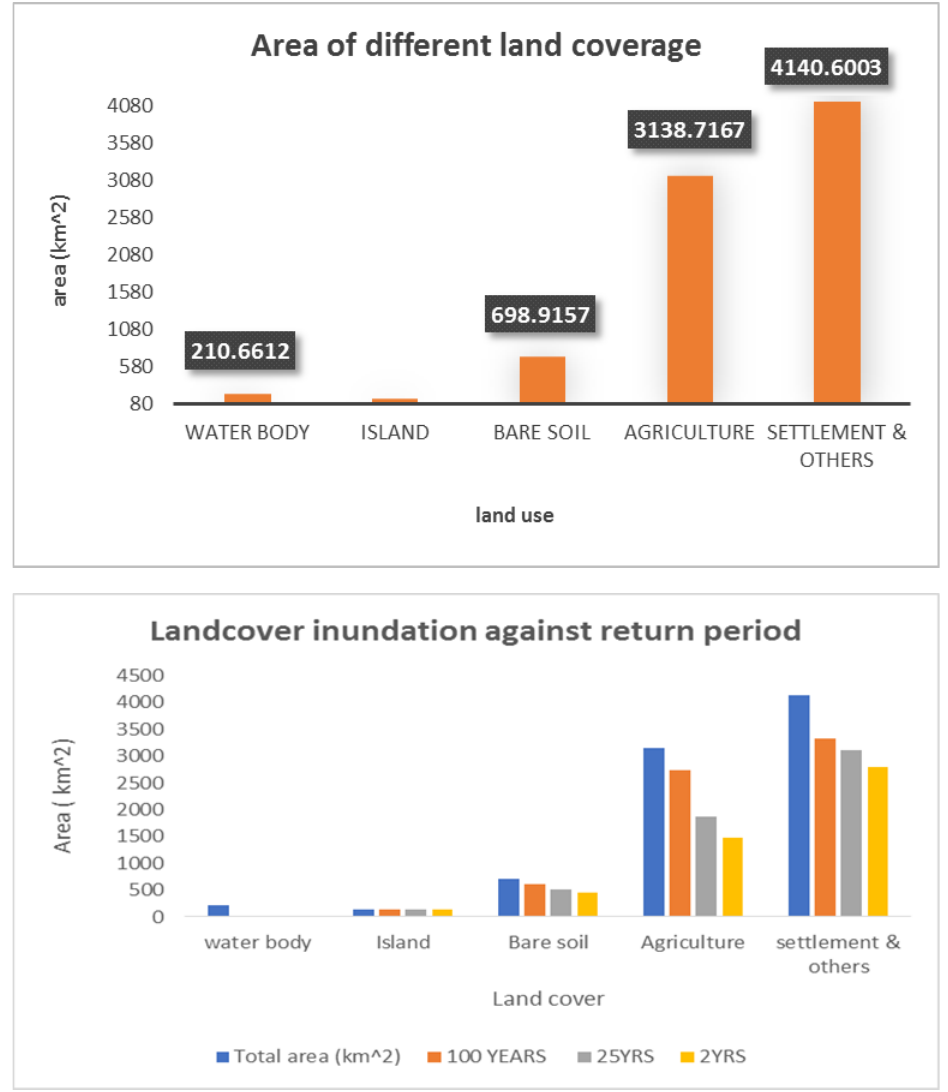
Fig. 11. area of inundation for land use for the different return